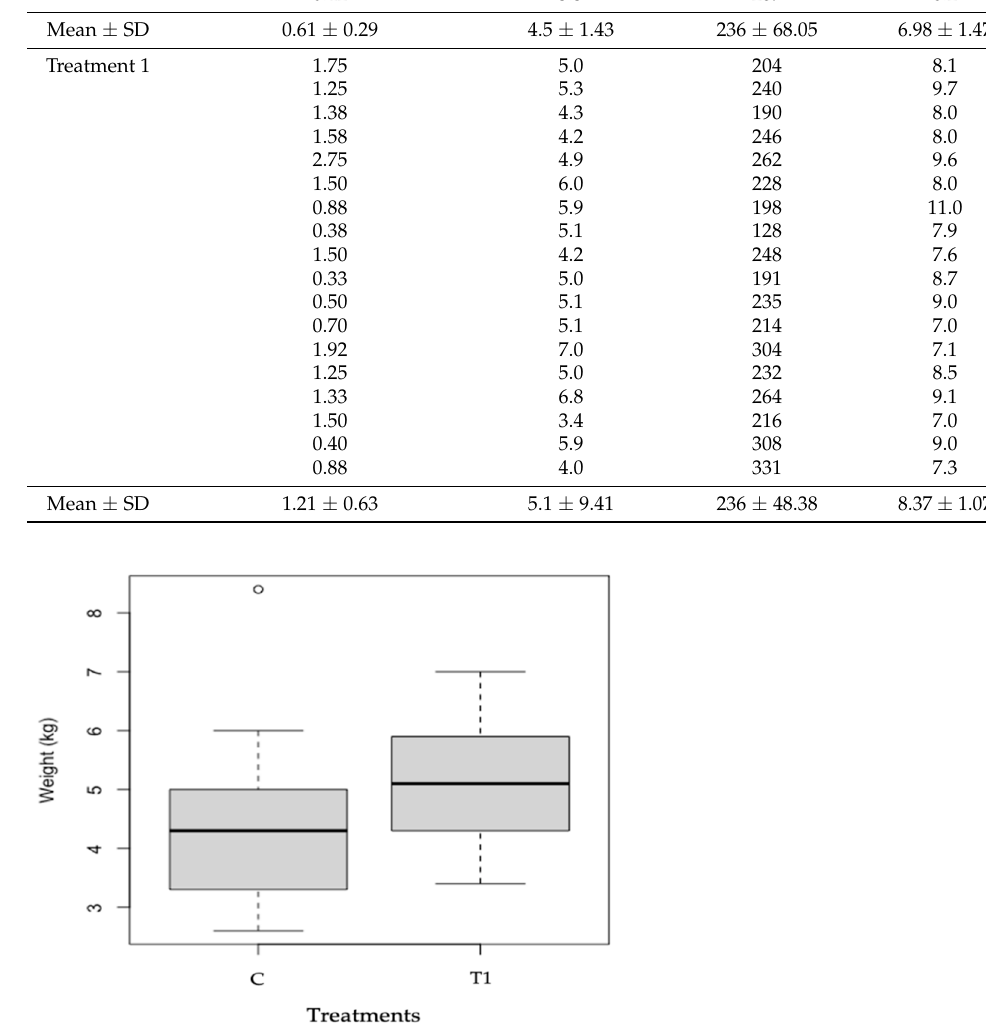
Figure 3. Weight of Cucurbita maxima var. Paine individuals in both study plots. C = control, T1: Treatment 1.